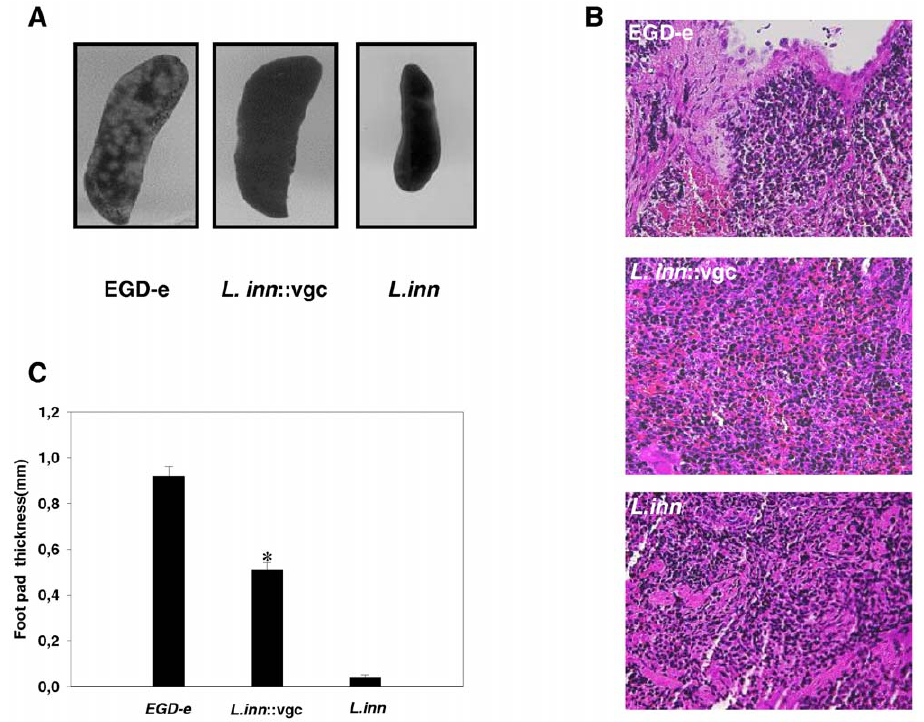
Figure 3. Examination of spleens and DTH response after infection with Lm and the recombinant L.inn::vgc strain. A. Morphological examination of spleens from mice inoculated i.v. with the wild type Lm and the recombinant L.inn::vgc strain. Spleens of mice infected i.v. as mentioned in Fig. 1 were isolated on day 3 after infection. Shown is a spleen from mice infected with the wild type Lm , the wild type L.inn and its recombinant mutant strain L.inn::vgc . Infiltration of monocytic cells and granulomatous lesions are only detectable in the spleens isolated from mice infected with the wild type Lm . B. Spleen sections were stained with HE and examined. Granulomas with massive leukocyte aggregates can only be detected in spleens of mice infected with Lm . C. DTH response to listerial antigen 9 days after primary infection. Mice were infected with 10 3 CFU of Lm , 10 7 CFU of L.inn , or 10 7 CFU of L.inn::vgc strain. 9 days after infection, DTH was triggered through injection of soluble somatic listerial antigen. Twenty-four hours later, the specific skin response was determined. The mean value 6 S.E. of five animals of a representative experiment is shown.*P , 0.05 (EGD-e vs. L.inn::vgc strain).